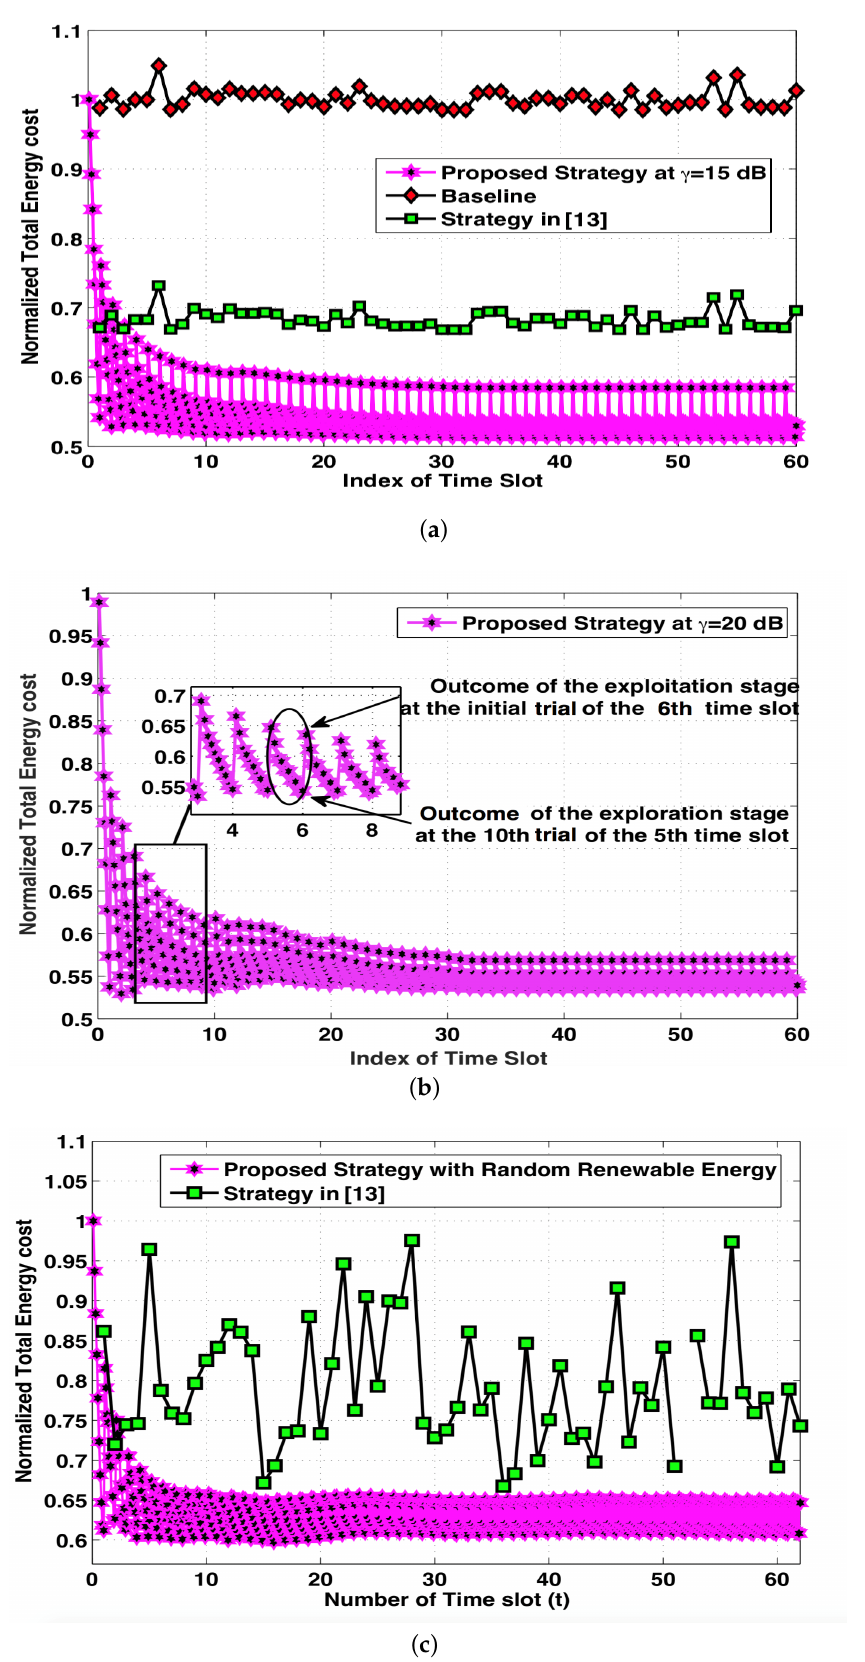
Figure 3. Normalized total energy cost at ( a ) γ = 15, ( b ) γ = 20, and ( c ) γ = 20 dB with random variations in renewable